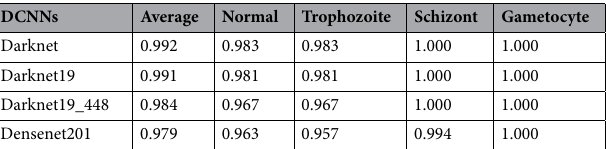
Table 1. Model-wise comparison and multiclass-wise comparison based on the accuracy from one-class versus total.